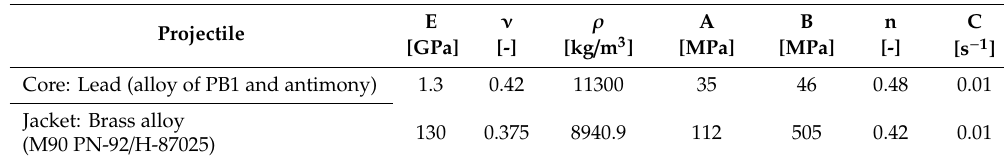
Table 4. Material properties of the projectile [44,47].